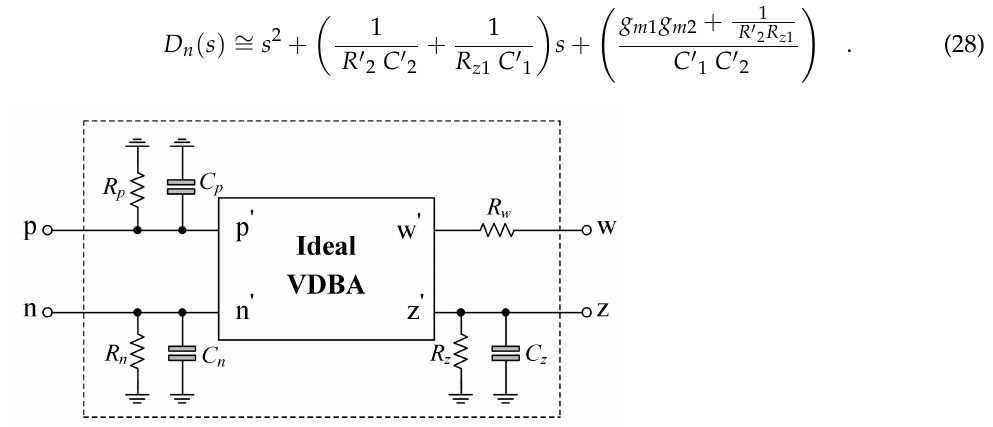
Figure 4. Non-ideal equivalent circuit of the